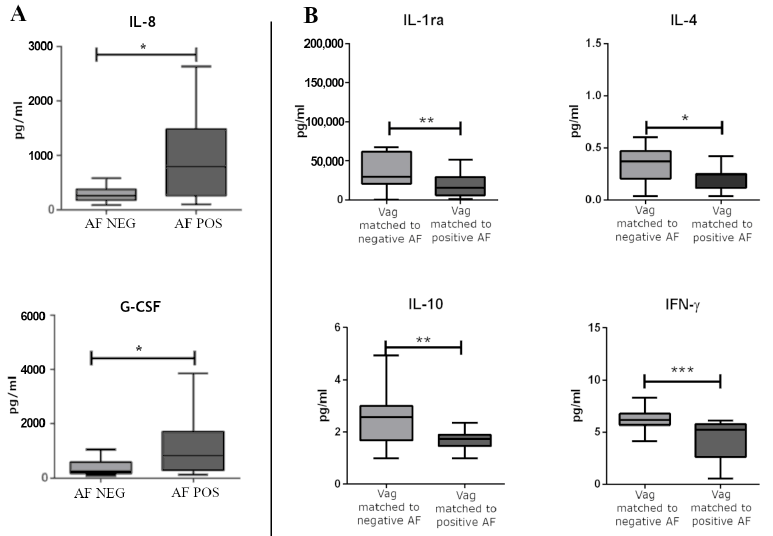
Figure 5. ( A ) The significantly modulated immune soluble factors between AF samples positive for bacterial DNA and AF samples negative for bacterial DNA. ( B ) The significantly modulated im- mune soluble factors between vaginal swabs matched to negative and positive AF samples for bac- terial DNA. Differences were calculated by means of a non-parametric T test for pairwise compari- sons (GraphPad Prism v. 5). * p < 0.05, ** p < 0.01, *** p <